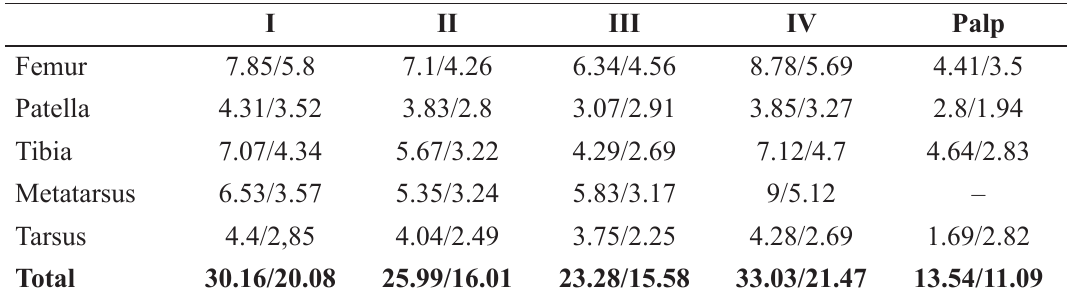
Table 3. Length of legs and palpal segments of holotype, ♂ (MZSP 28411) / paratype, ♀ (MZSP 28412) of Schismatothele merida sp.